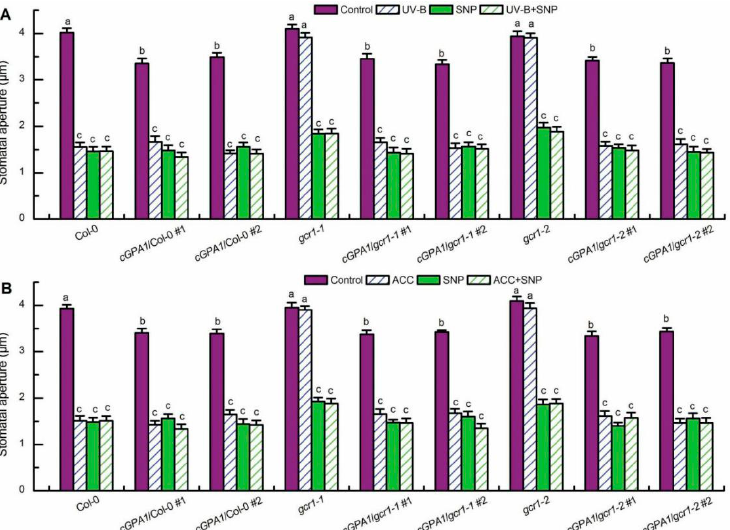
Figure 5. GCR1 mediated UV-B- and ethylene-induced NO generation in guard cells via activating G α subunit GPA1. Leaves of the wild-type Col-0, gcr1 mutants, and transgenic plants cGPA1/Col- 0/gcr1-1/gcr1-2 were floated on MES buffer in the absence or presence of 400 ng/mL CTX (CTX) or 100 μ mol/L ACC (ACC) and exposed to light alone (Control) or with 0.5 W/m 2 UV-B (UV-B) for 3 h. Then the images ( A ) and fluorescence intensities ( B ) of guard cells preloaded with DAF-2DA were recorded. For ( A ), scale bar = 10 μ m. For ( B ), data are shown as means ± SE ( n = 3), each with 20 stomata. Means with different letters are significantly different at p < 0.05.